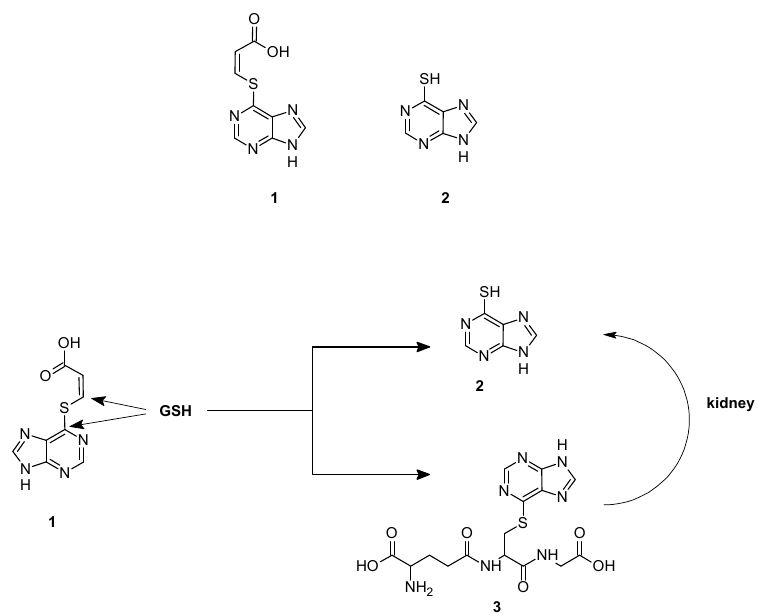
Figure 2. Chemical structure and mechanism of activation of cis -3-(9 H -purin-6-ylthio) acrylic acid ( 1